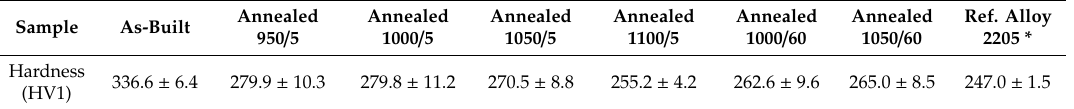
Table 3. Microhardness (HV1) and its standard deviation of the SLM duplex stainless steel for di ff erent annealing treatments. Cold-rolled and annealed reference alloy 2205 is included for